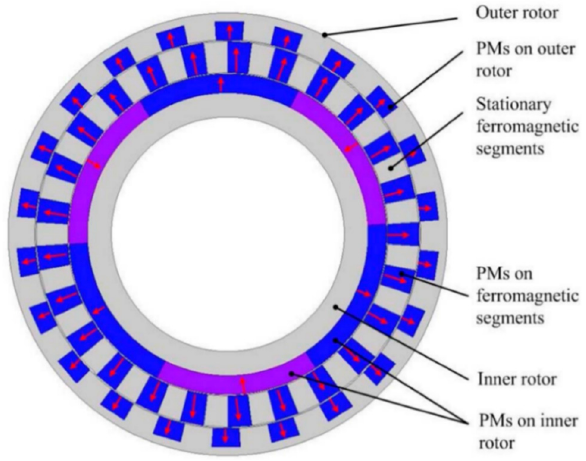
Figure 22. Configuration of a triple-PM magnetic gear [55].